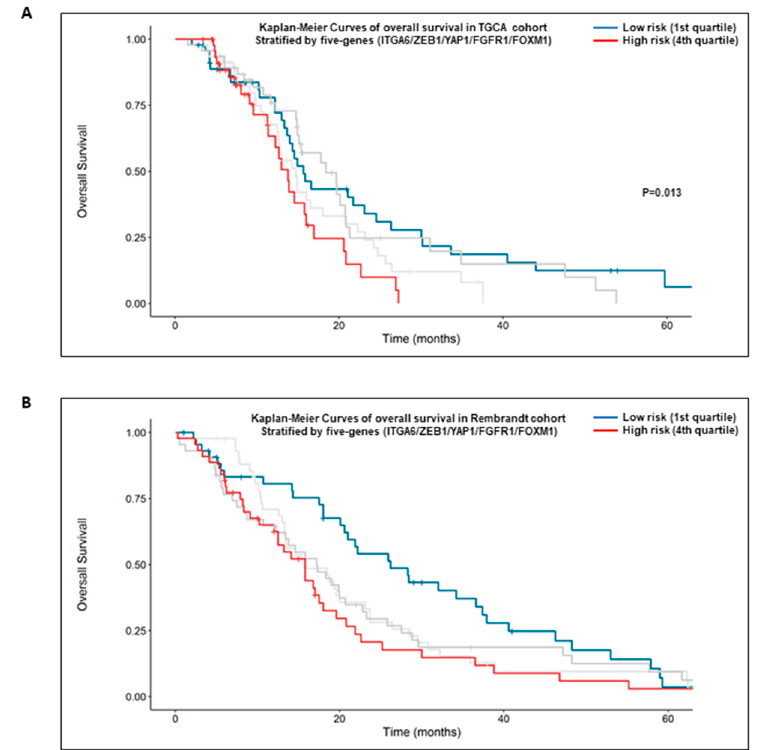
Figure 7. High expression of the five genes signature: α 6-integrin/ZEB1/YAP1/FGFR1/FOXM1 is prognostic of survival of GBM patients. Kaplan-Meier curves depict the probability of overall survival based on the expression of a five genes signature: α 6-integrin/ZEB1/YAP1/FGFR1/FOXM1. Analysis was performed from TGCA ( A ) or Rembrandt ( B ) databases. Patients were stratified by the upper or lower quartiles and the statistical analysis performed as described in section “Materials and Methods”.